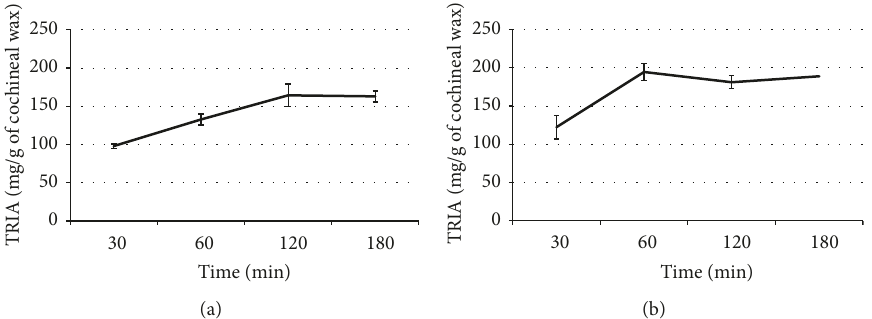
Figure 6: Enzymatic transesterification reaction assisted by orbital agitation with (a) butanol and (b) isopropanol as acyl receptor, in toluene reaction medium.